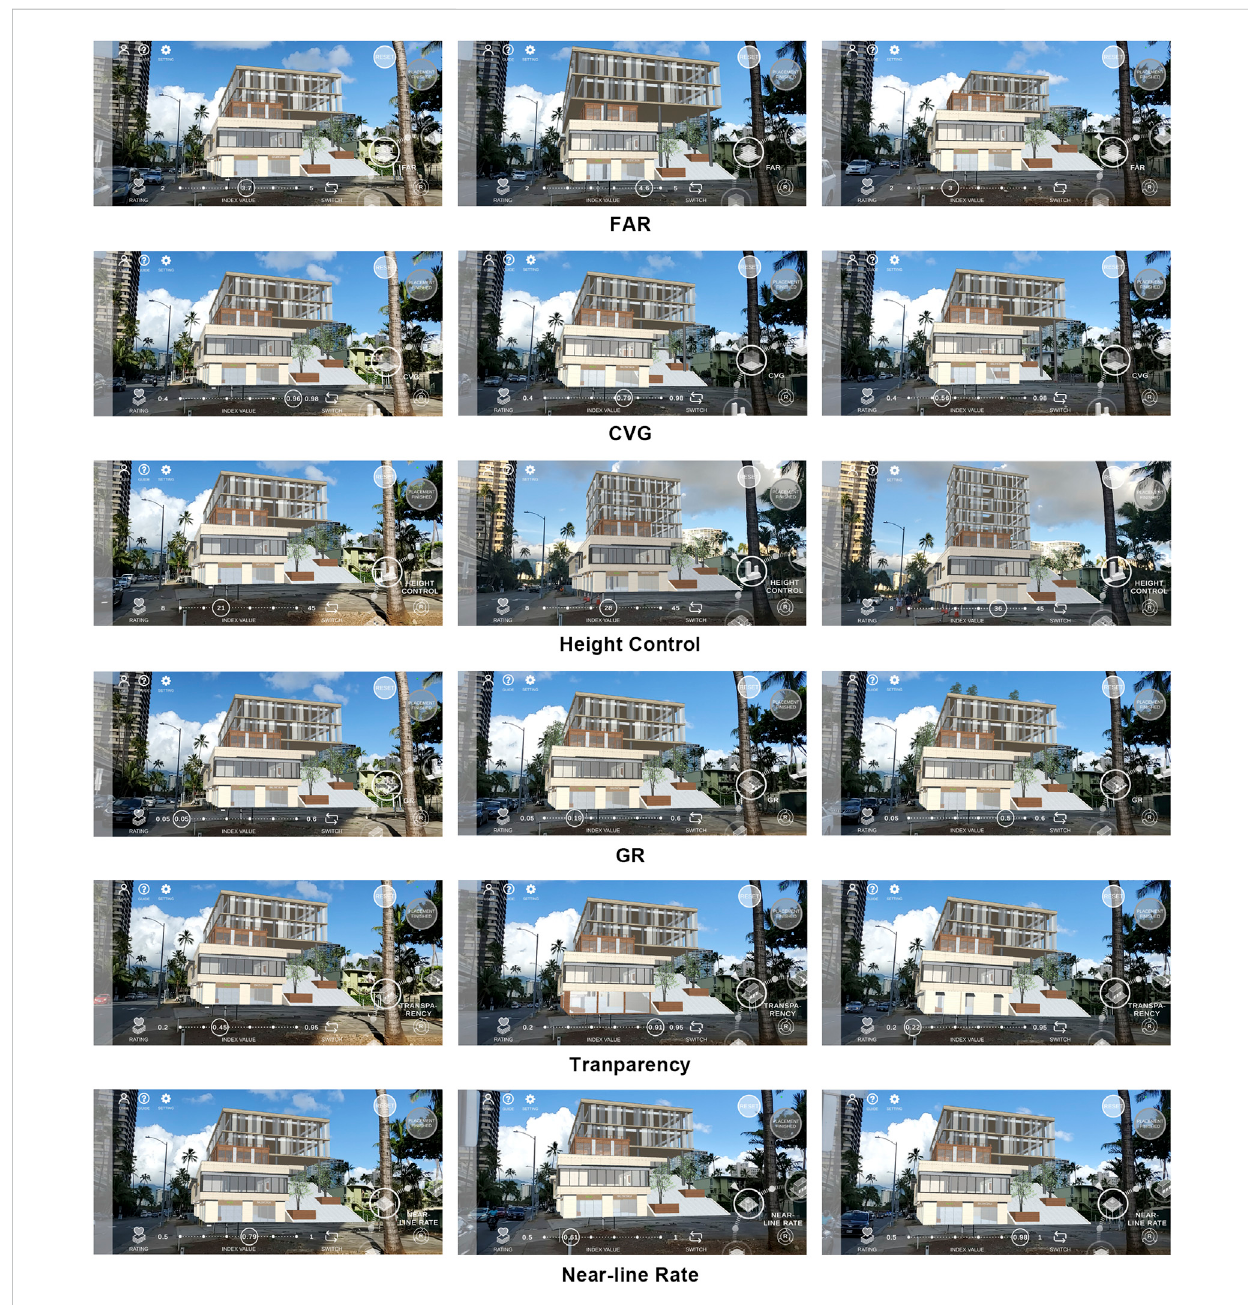
FIGURE 8 Views from another position. Created with Unity Personal version and AR Foundation